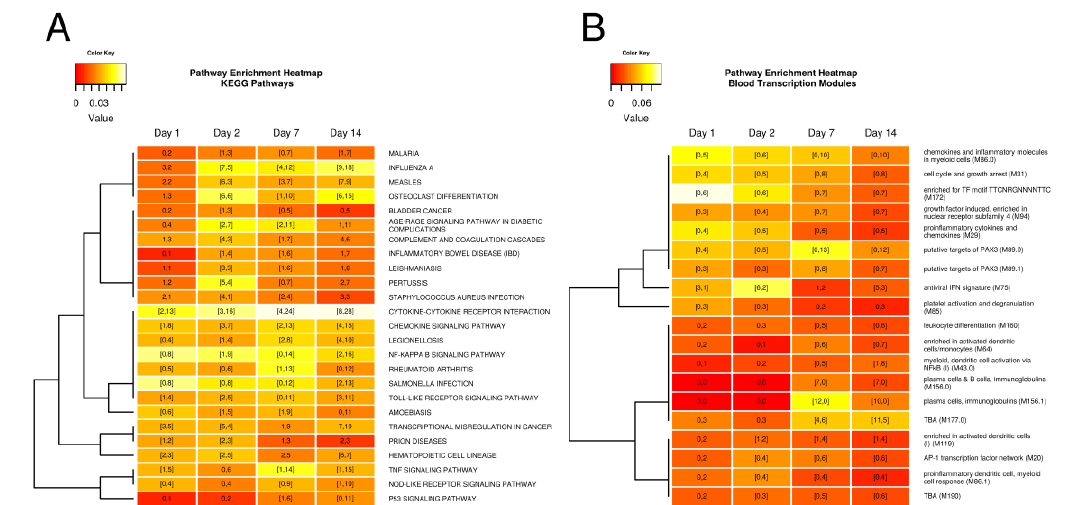
Figure 2. Heatmap of pathways that were enriched in PBMC DE genes. ( A ): KEGG pathways. ( B ): Blood Transcription Modules. Pathways significantly enriched in at least two conditions are shown. Cells are color coded by the Jaccard Similarity Index which measures the agreement between DE genes and pathways. Lighter colors indicated stronger agreement. Cells contain the number of DE genes in a pathway with DE gene numbers in brackets indicating significantly enriched sets. The first number indicates up-regulated DE genes, the second number represents down-regulated DE genes. Pathways were clustered based on the Jaccard distance between their binary enrichment pattern.